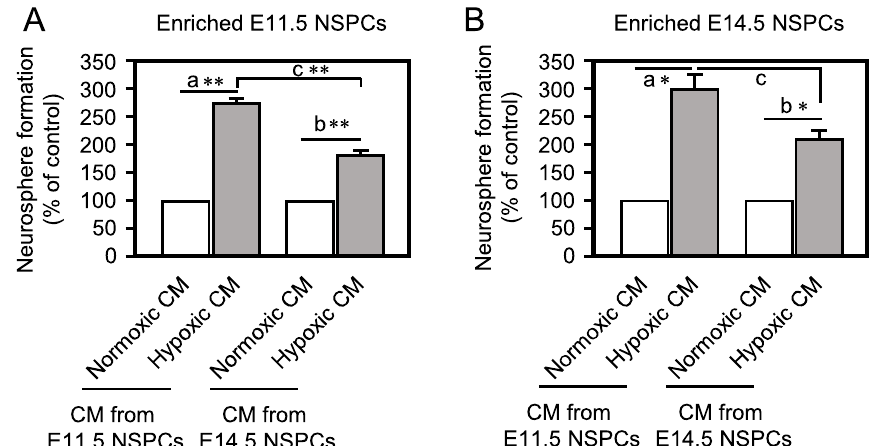
Fig. 4. Hypoxic CM from younger NSPCs effectively enhance neurosphere formation. A Neurosphere assay of enriched E11.5 NSPCs under the normoxic or hypoxic CM prepared from enriched E11.5 or E14.5 NSPCs. (mean Neurosphere assay of enriched E14.5 NSPCs under the normoxic or hypoxic CM prepared from enriched E11.5 or E14.5 NSPCs. (mean a p 0.0246, b p 0.0262, c p = = =